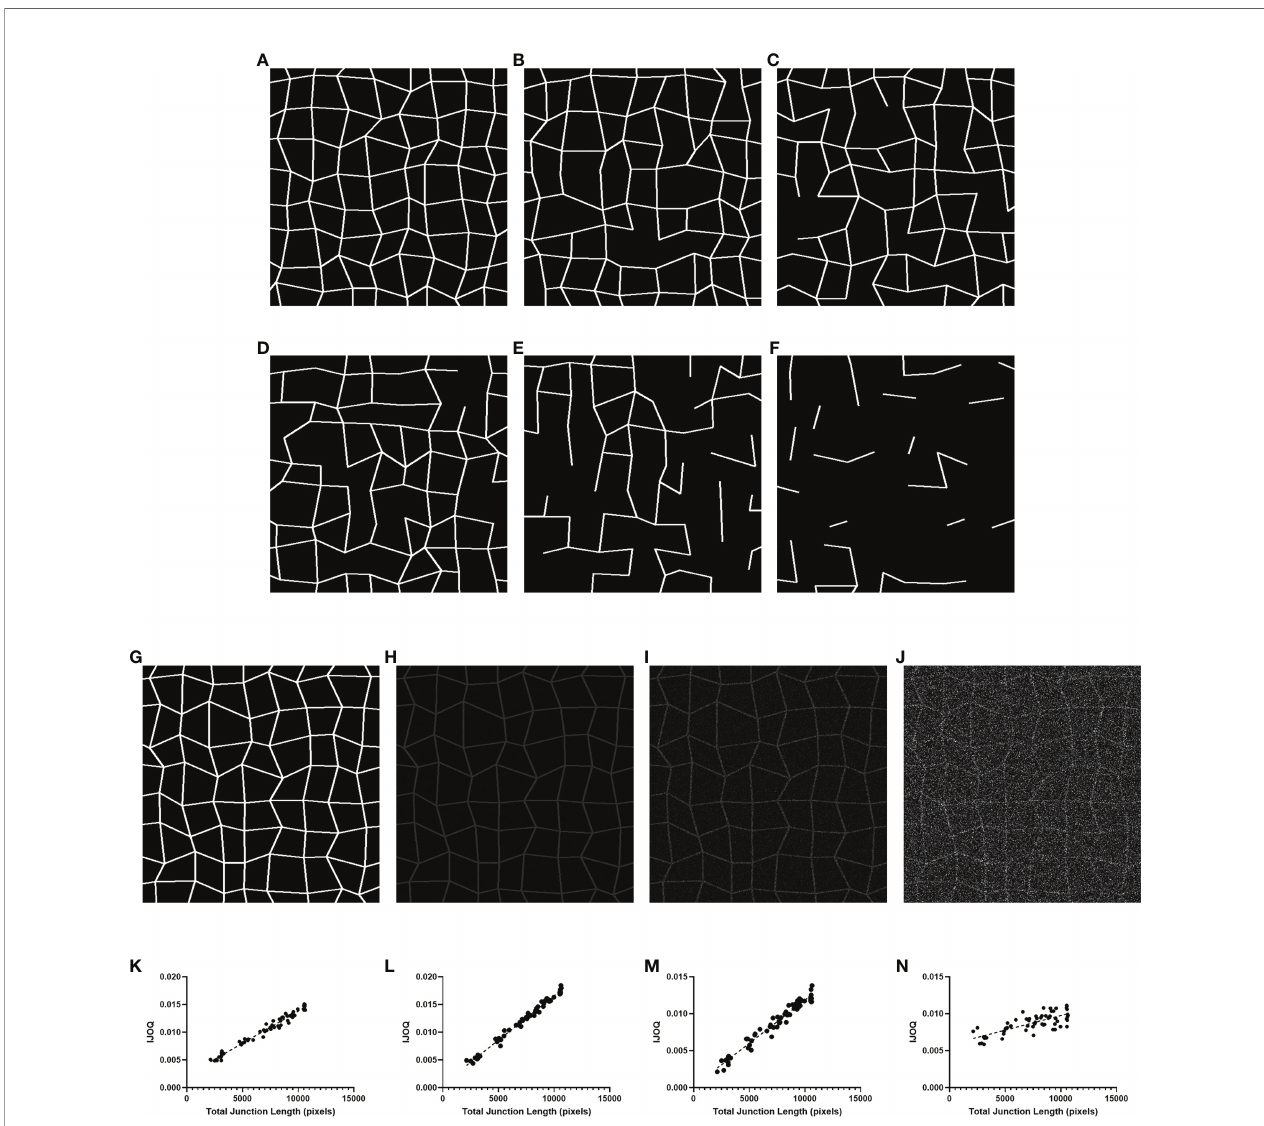
FIGURE 3 | IJOQ versus total junction length in simulated images. Examples of simulated cell monolayer images. IJ disruption was simulated at (A) 0%, (B) 10%, (C) 20%, (D) 30%, (E) 50%, and (F) 70%, respectively. (G) An example of the original simulated image with no noise applied. Additive noise was applied to reach (H) a signal-to-noise ratio of 10, (I) a signal-to-noise ratio of 2 and (J) a signal-to-noise ratio of 0.5. IJOQ shows a strong linear correlation under (K) ideal conditions (r 2 = 0.975), (L) a signal-to-noise ratio of 10 (r 2 = 0.989), (M) a signal-to-noise ratio of 2 (r 2 = 0.963) and (N) a signal-to-noise ratio of 0.5 (r 2 = 0.579) as determined by linear regression